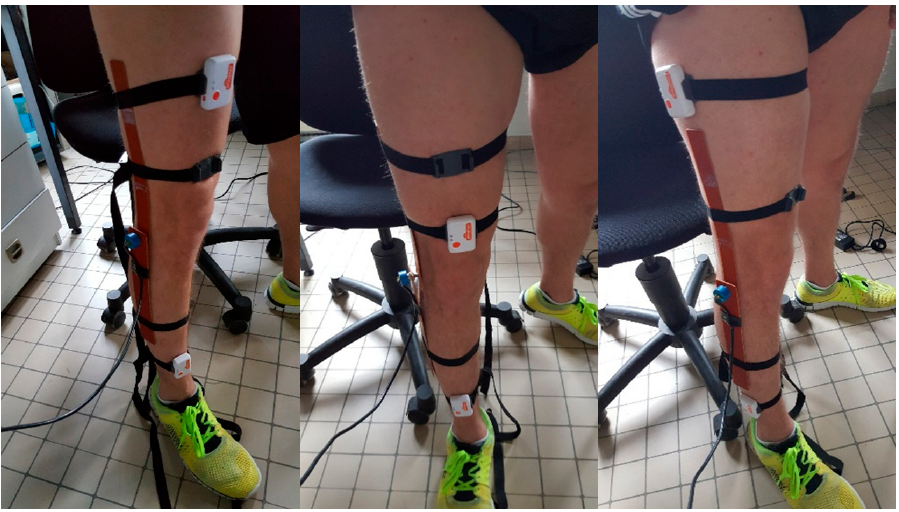
Figure 4. Tested sensor positions ( Left : Sensor on the thigh directly; Middle : Sensor above the kneecap; Right : Sensor in the sagittal plane).